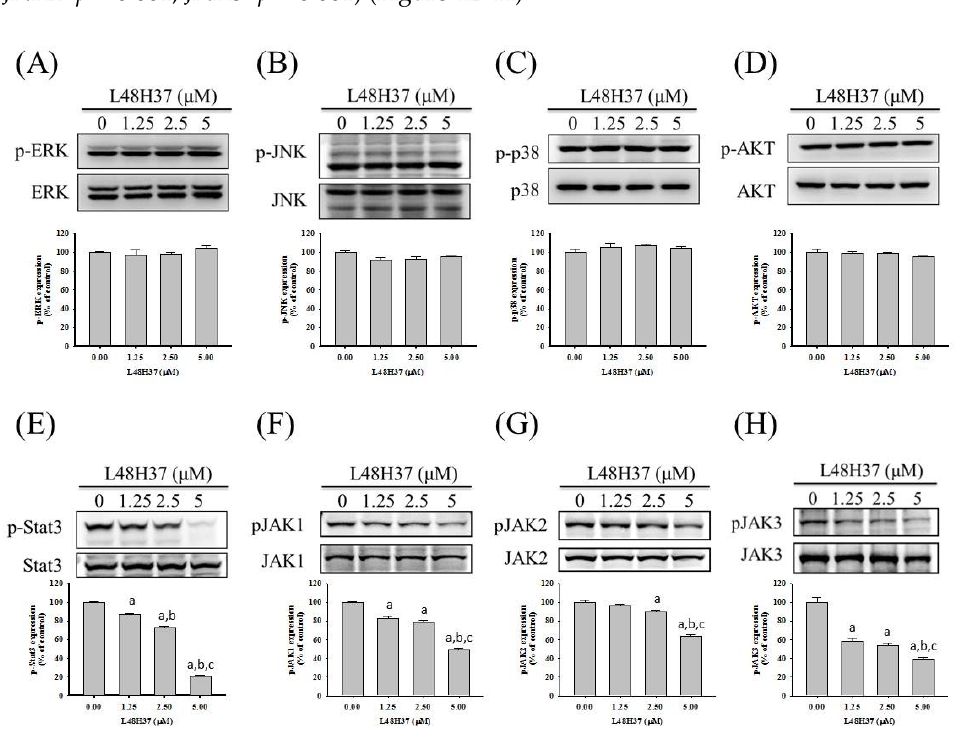
Figure 4. Effects of L48H37 on MAPKs, PI3K-Akt, STAT3, and JAK1/2/3 in U2OS cells. Western blotting analyses for the total or phosphorylated forms of ( A ) ERK, ( B ) JNK, ( C ) p38, ( D ) Akt, ( E ) STAT3, ( F ) JAK1, ( G ) JAK2, and ( H ) JAK3 after treatment with L48H37 at various concentrations (0,